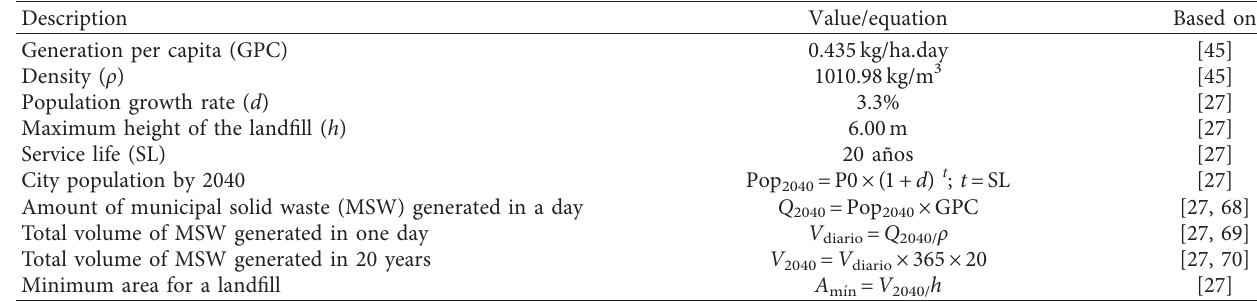
Table 4: Data for estimating the minimum area for the landfill.